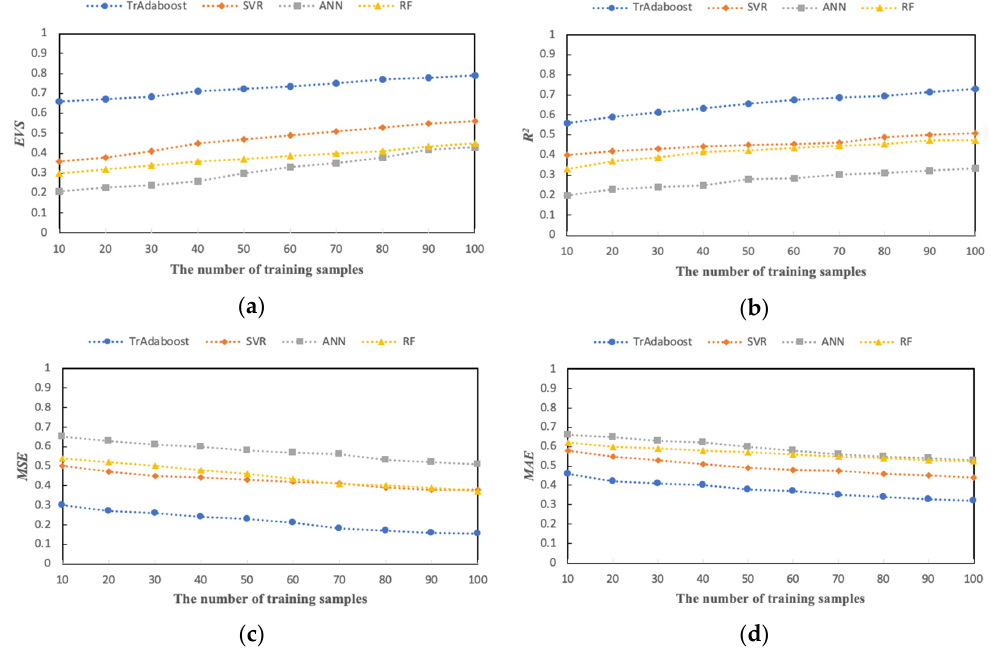
Figure 9. The performances of prediction model with KAFPs selection. (( a ) EVS ; ( b ) R 2 ; ( c ) MSE ; ( d ) MAE )